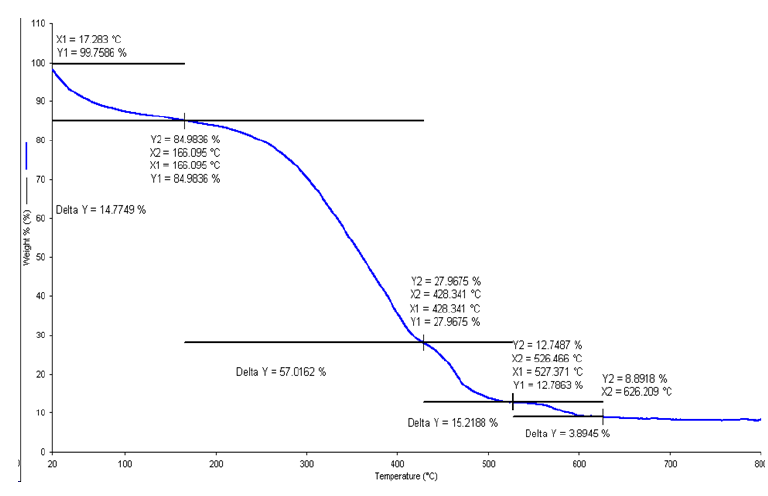
Figure 14. Thermogravimetric profile of the percentage weight loss for Ca 2+ /Dop − B.